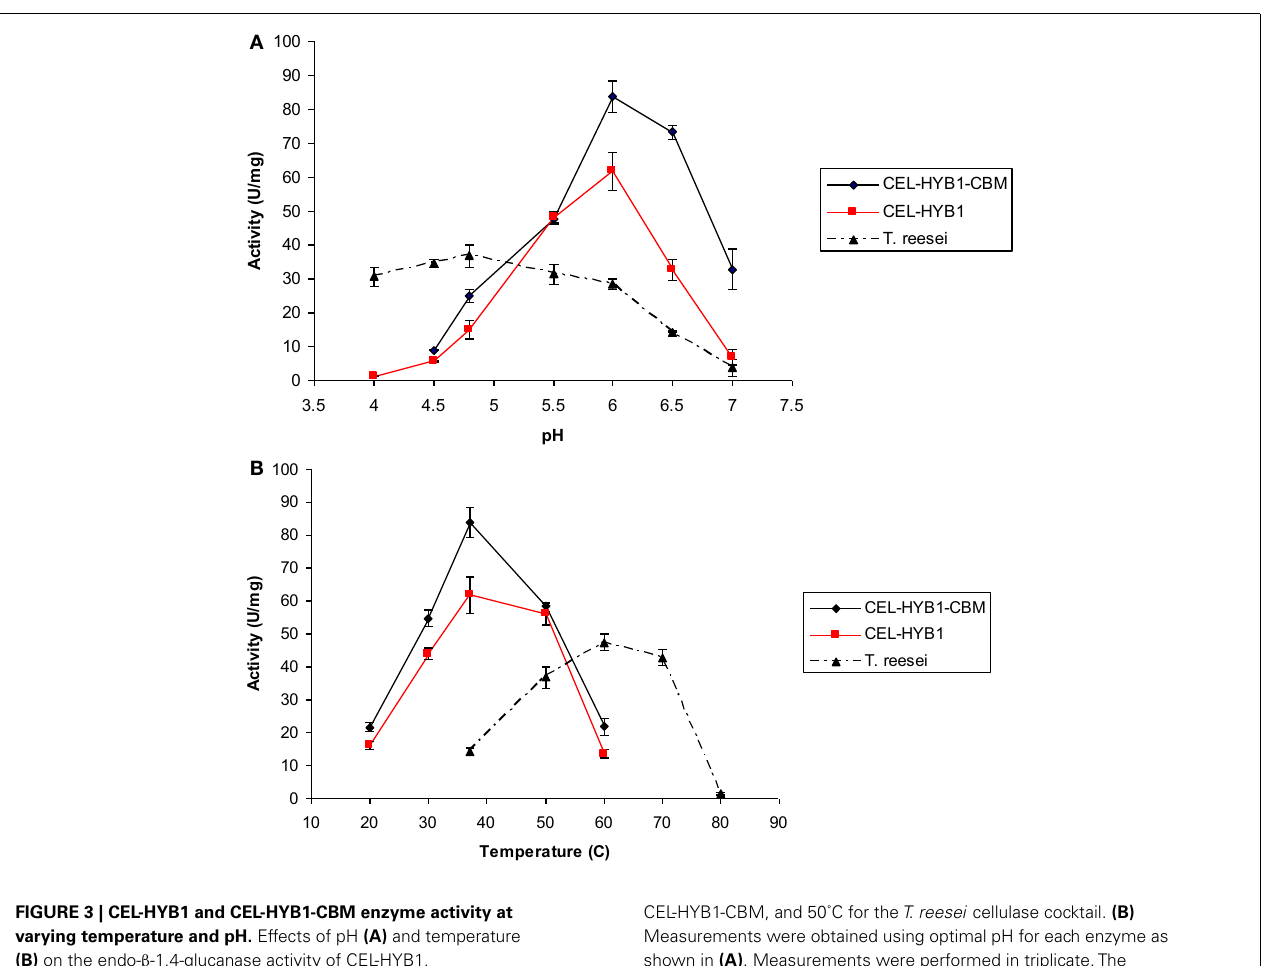
FIGURE 3 | CEL-HYB1 and CEL-HYB1-CBM enzyme activity at varying temperature and pH. Effects of pH (A) and temperature (B) on the endo- β -1,4-glucanase activity of CEL-HYB1, CEL-HYB1-CBM, and T. reesei cellulase enzymes. Measurements shown in (A) were performed at 37˚C for CEL-HYB1 and